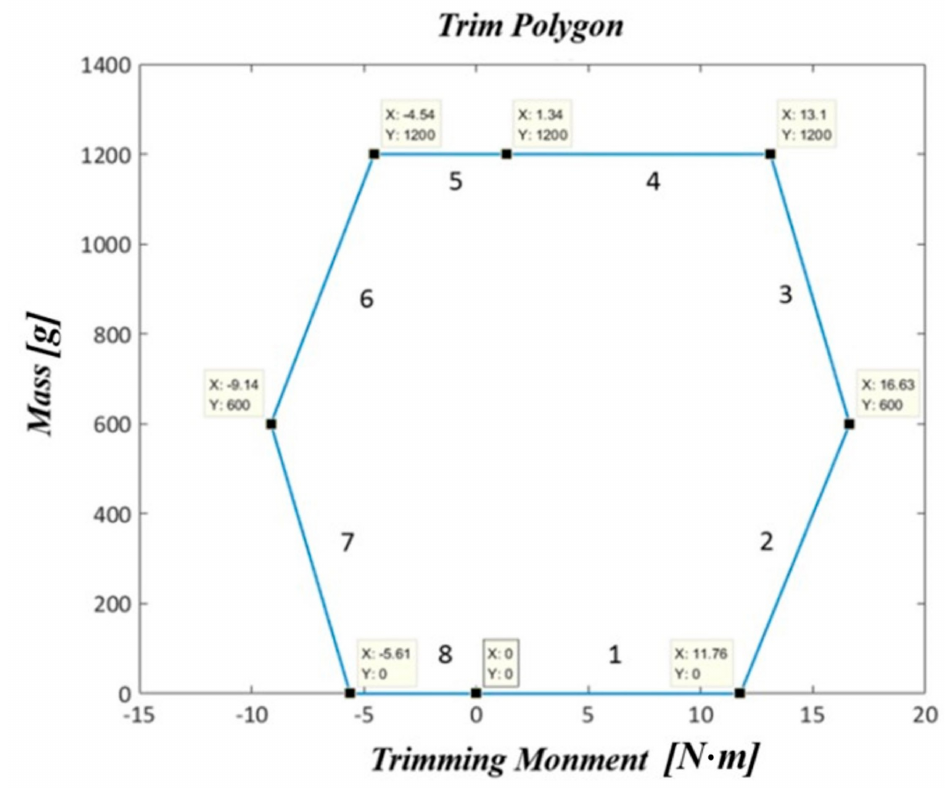
Figure 11. The trim polygon of the SFRM.